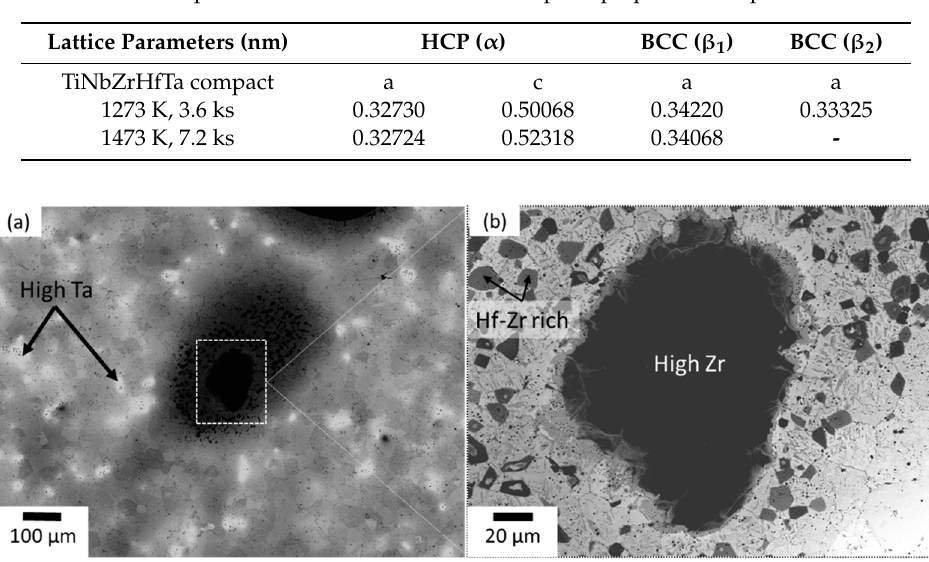
Figure 4. XRD patterns of the TiNbZrHfTa compact prepared from pure elemental powders. Table 4. Lattice parameters of the TiNbZrHfTa compacts prepared from pure elements.